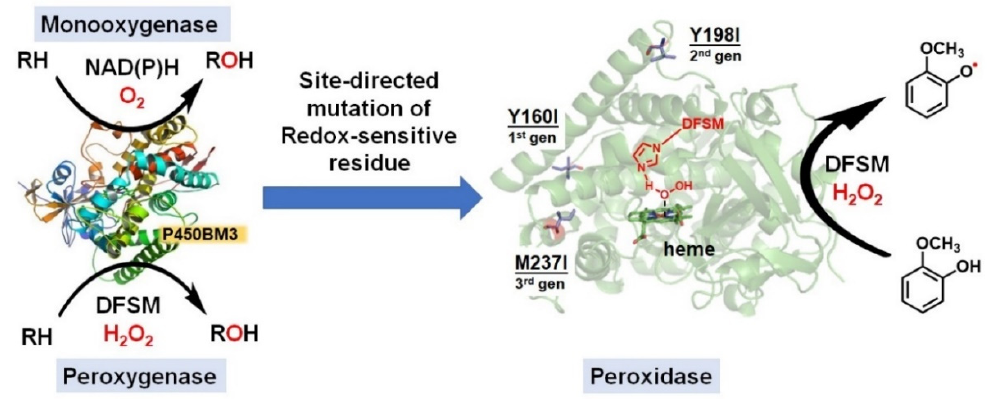
Figure 7. Native monooxygenase activity. DFSM-facilitated peroxygenase activity and switching to peroxidase activity by mechanism-guided protein engineering.